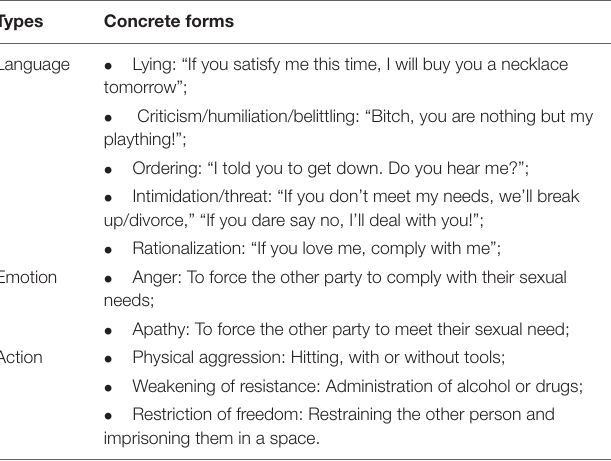
TABLE 1 | Examples of ways to achieve sexual